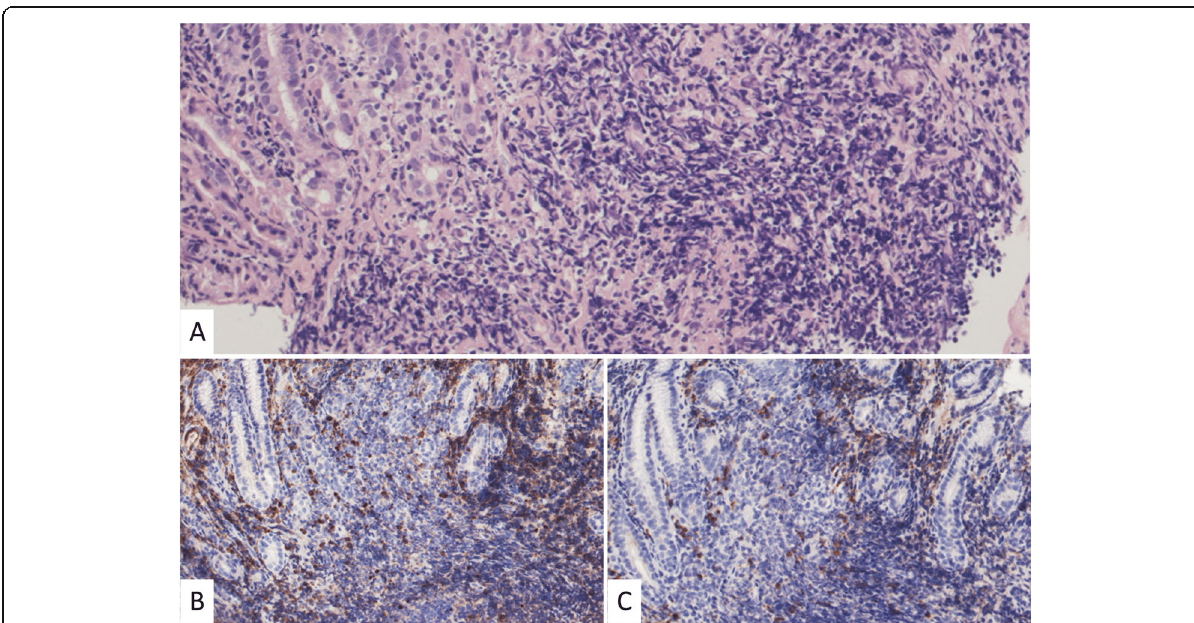
Fig. 3 Histopathological findings of the stomach lesion showing lymphocytic infiltration without any atypical cells in the hematoxylin and eosin staining ( a ) or any light chain restriction between the kappa ( b ) and lambda ( c ) chains in the immunostaining, consistent with inflammatory changes. We used antibodies with the product number n1510 (company, DAKO; dilutions, 5 times for the kappa chains) and product number ncl-lam (company, Leica; dilutions, 200 times for the lambda chains). The positive cells are stained with a brown color